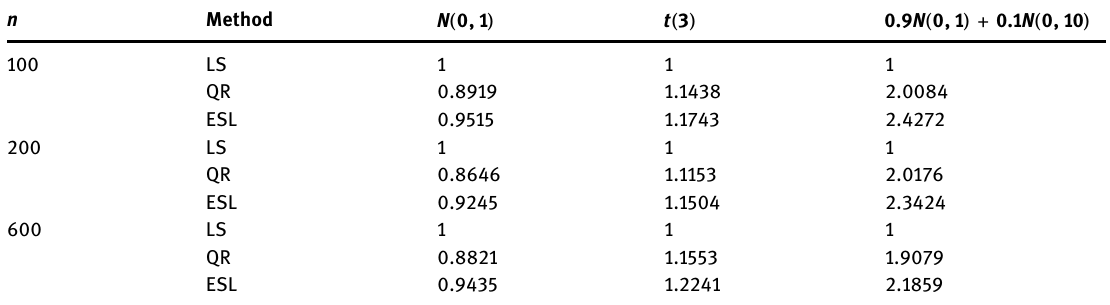
Table 4: Mean values of the RT values